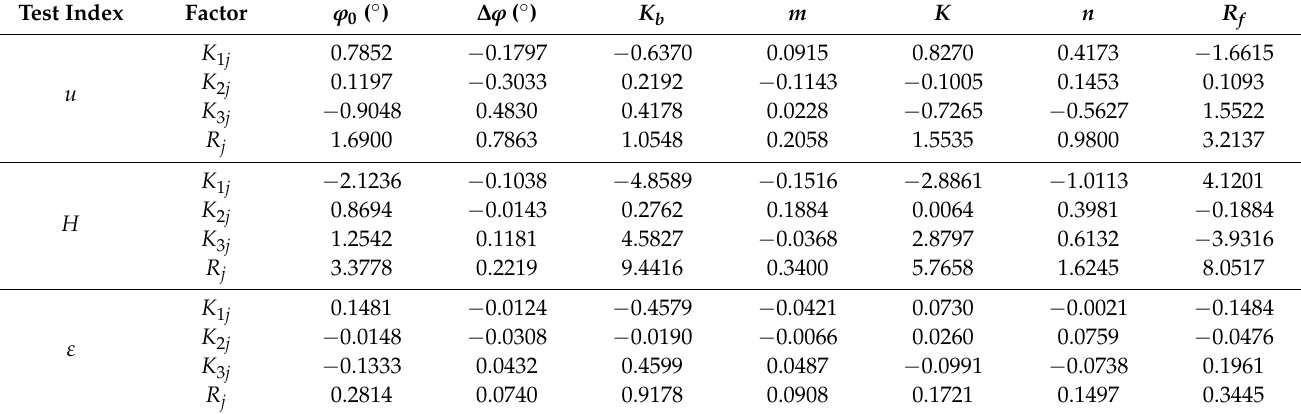
Table 8. Range analysis results of influencing factors of each test index for the main rockfill